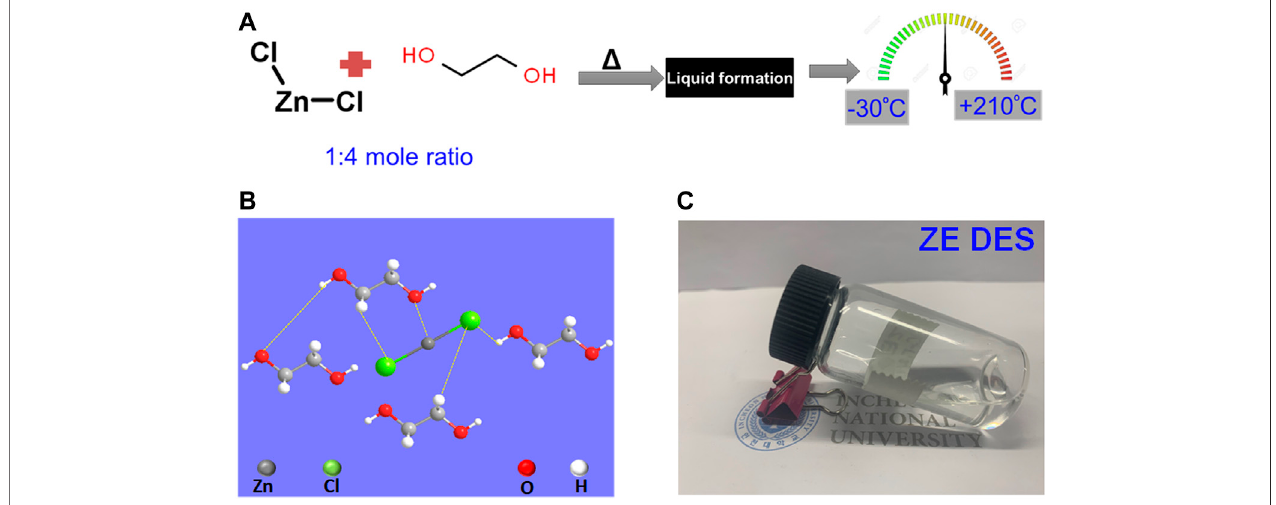
FIGURE 1 | (A) Synthesis scheme for the preparation of the ZnCl 2 – 4EG DES electrolyte. (B,C) Schematic and photographs of the ZE DES electrolyte.